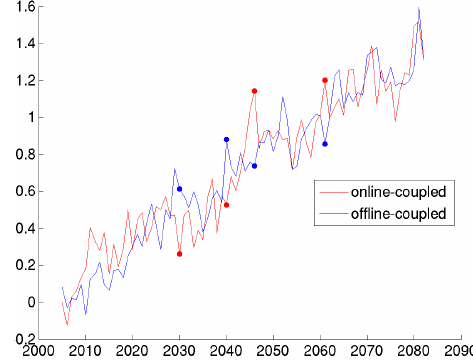
Figure 5. Projection coefficients for the online-coupled and offline- coupled model implementations for a pair of equivalent scenarios based on RCP4.5. The coefficients are derived by projecting the spatial pattern of annual mean surface air temperature onto the “fin- gerprint” of the surface air warming trend derived from the RCP8.5 ensemble mean. The fingerprint is taken to be the first empirical or- thogonal function of the 96-year time series of RCP8.5 annual mean surface temperatures, scaled so that its mean value is 1 ◦ C. Circles indicate values that differ between the online-coupled and offline- coupled simulations by more than the 95% confidence interval of this same metric calculated for the RCP4.5 6 member